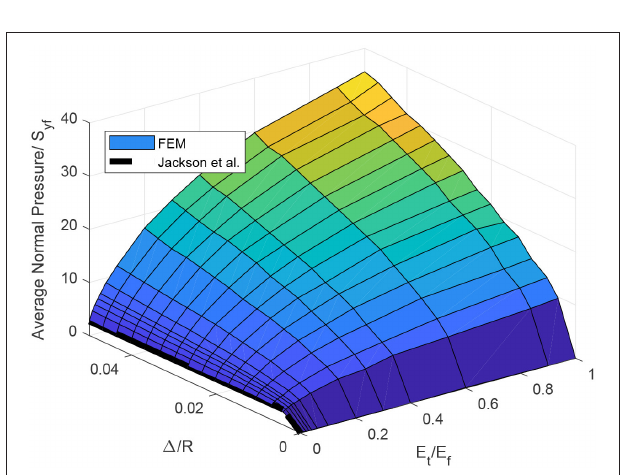
FIGURE 5 | Changes in the normal average pressure with respect to the strain hardening and applied displacement for material set 1 (numerical results).